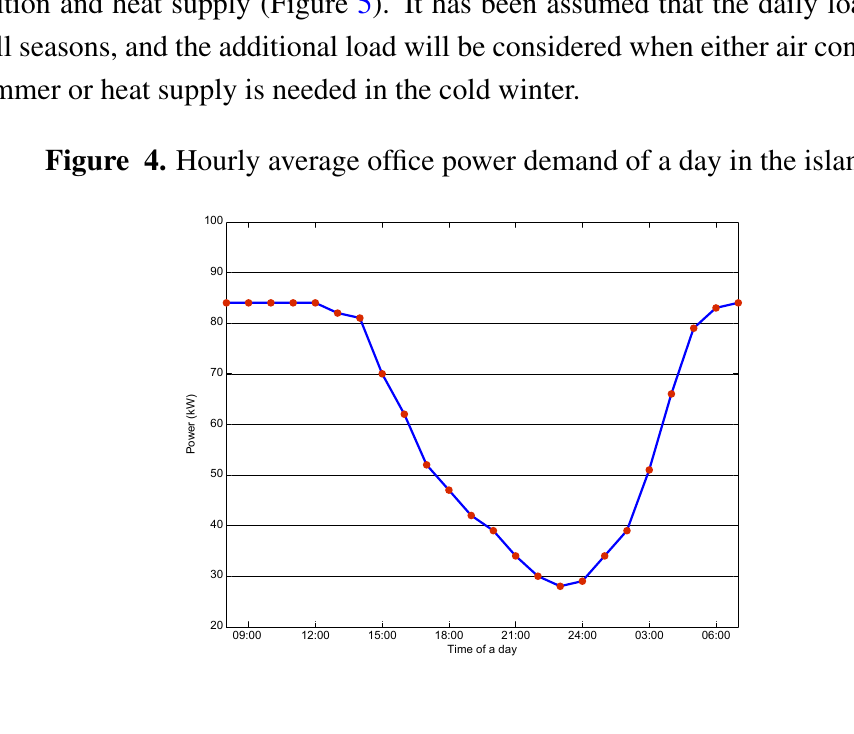
Figure 5. Load characteristic of air condition in summer and heat supply demand in